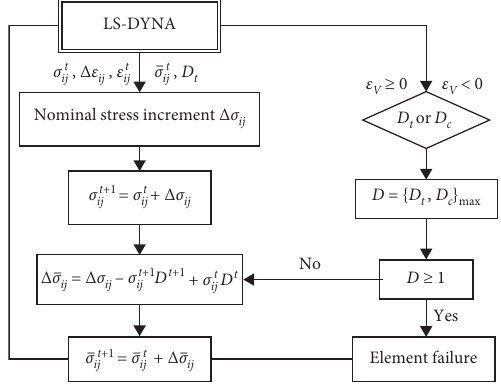
Figure 4: Flowchart of the dynamic damage subprogram.